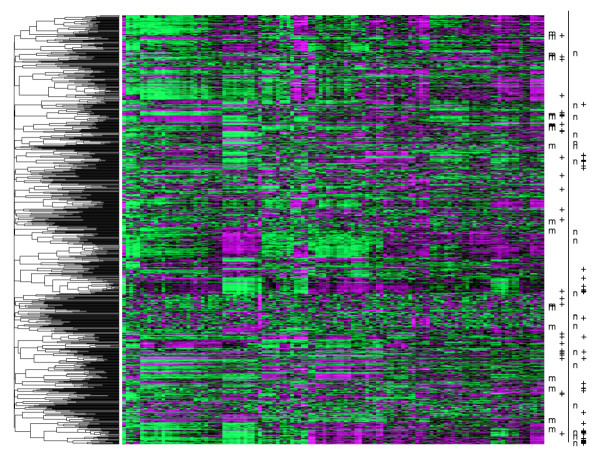
Hierarchical clustering of 40 genes involved in the isoprenoid pathway and 795 genes from other pathways. Clustering is depicted as a heatmap, in which red and green represent high and low expression values, respectively. Rows depict genes and columns depict hybridizations. Positions of the genes from the MEV pathway (m) and the plastoquinone and phytosterol pathways (+) are indicated in the left-hand column of the heatmap axis on the right side of the figure. Positions of the genes from the MEP pathway (n) and the plastoquinone, carotenoid and chlorophyll pathways (+) are indicated in the right column of the axis.